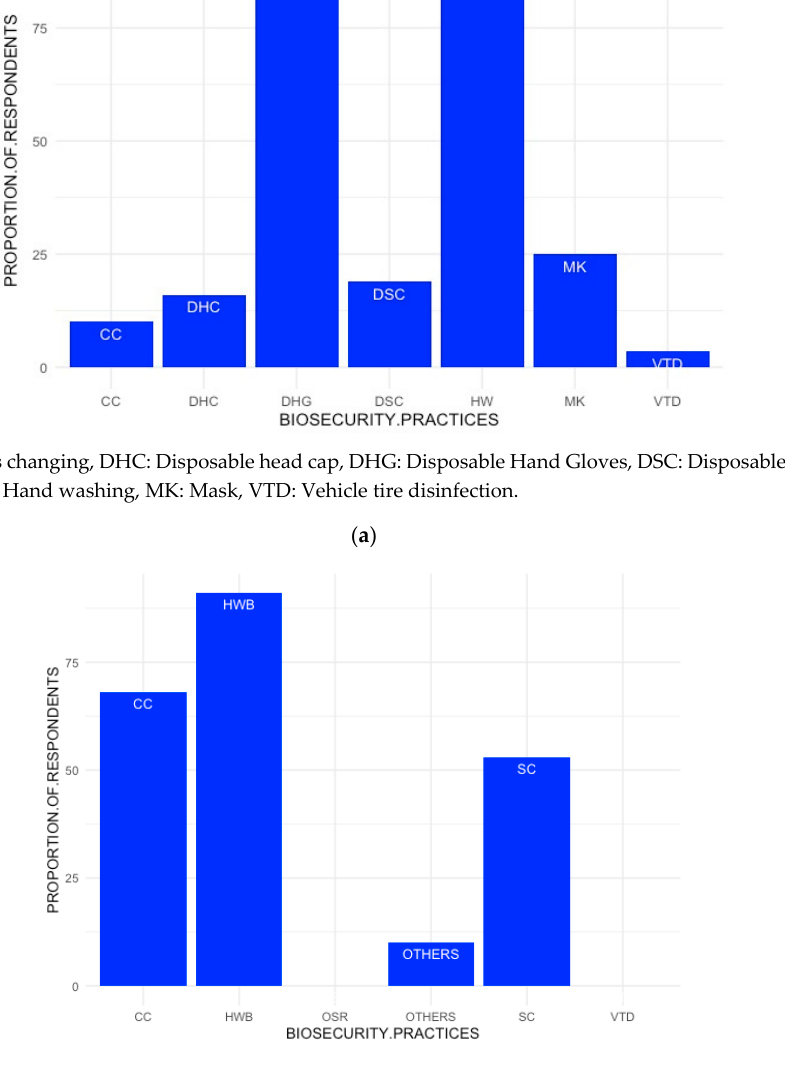
Figure 4. ( a ) The proportional distribution of the di ff erent biosecurity practices adopted by the veterinary professionals (veterinarians and paraveterinarians) while moving from farm to farm based on the responses received during dairy value chain study conducted in Punjab, India during 2018–2019; ( b ) the proportional distribution of the di ff erent biosecurity practices adopted by the veterinary professionals (veterinarians and paraveterinarians) on returning home from farm visits based on the responses received during dairy value chain study conducted in Punjab, India during